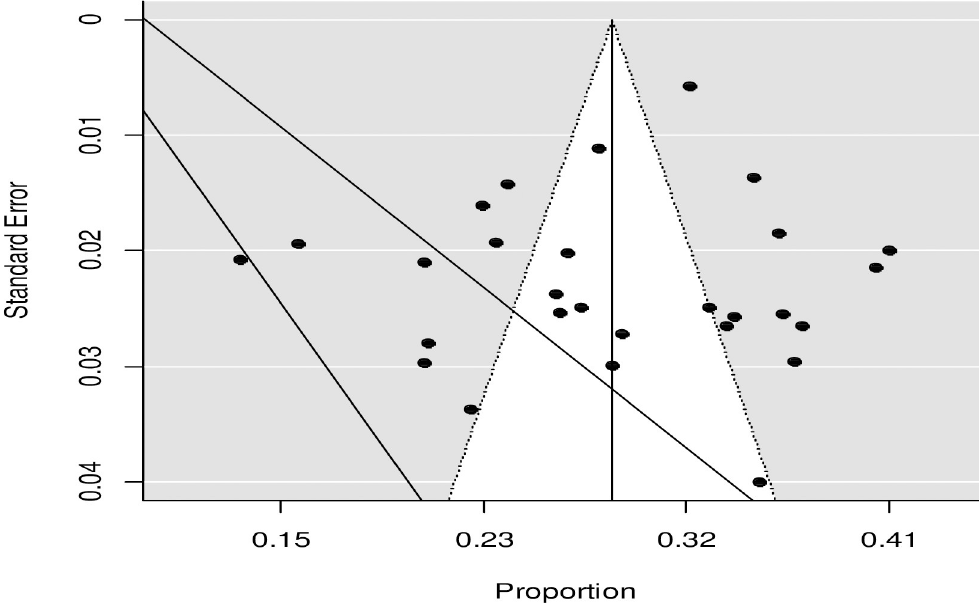
Fig 3. Funnel plot of the prevalence of unintended pregnancy in